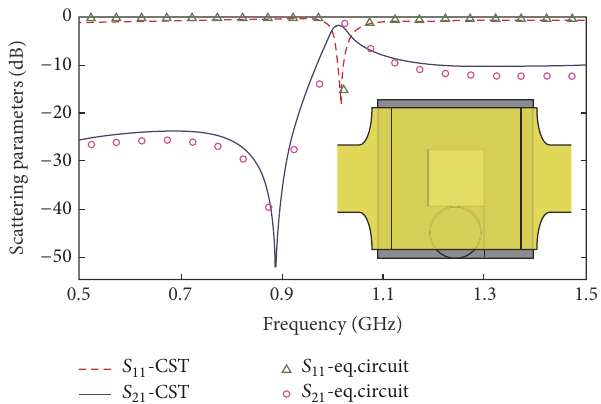
Figure 3: Scattering parameters of the DNG cell. The elements of the equivalent circuit are extracted as 𝐶 󸀠 𝑝 = 4.396 pF, 𝐿 󸀠 𝑝 = 7.308 nH, 𝑅 = 0.6 Ω , 𝐶 󸀠 = 10.24 pF, 𝐿 = 4.182 nH, and 𝐶